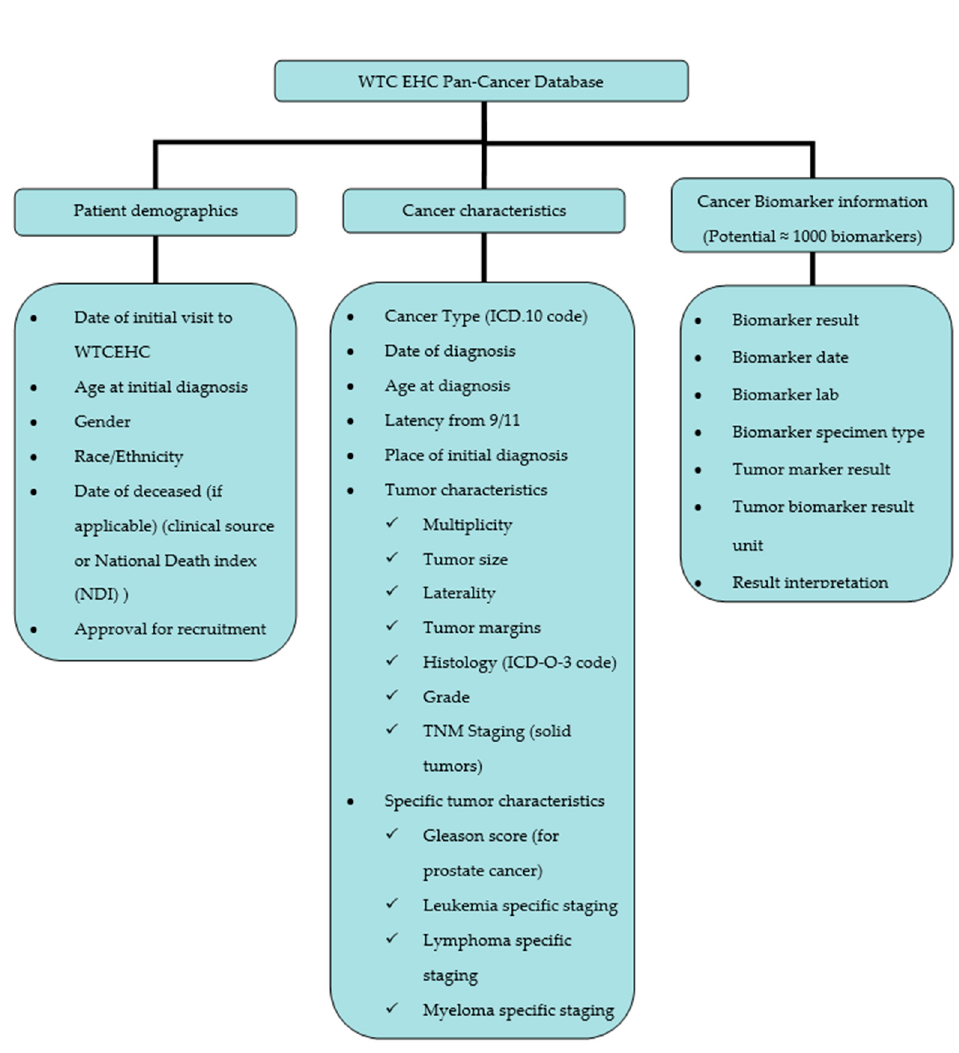
Figure 1. WTC EHC pan-cancer database overview.